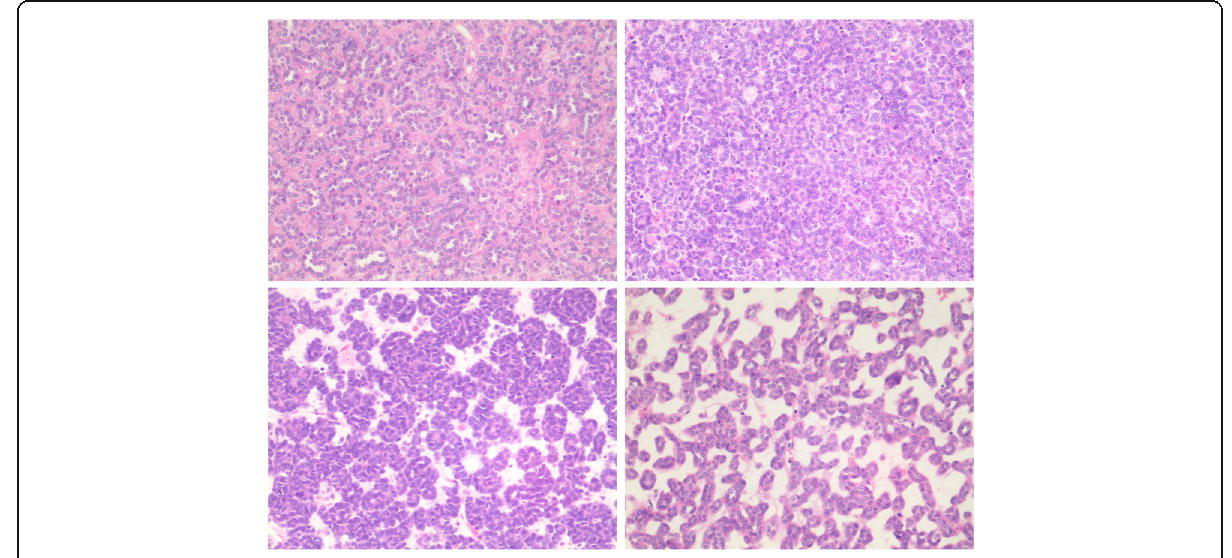
Fig. 1 Representative images of H&E stataining of MA,